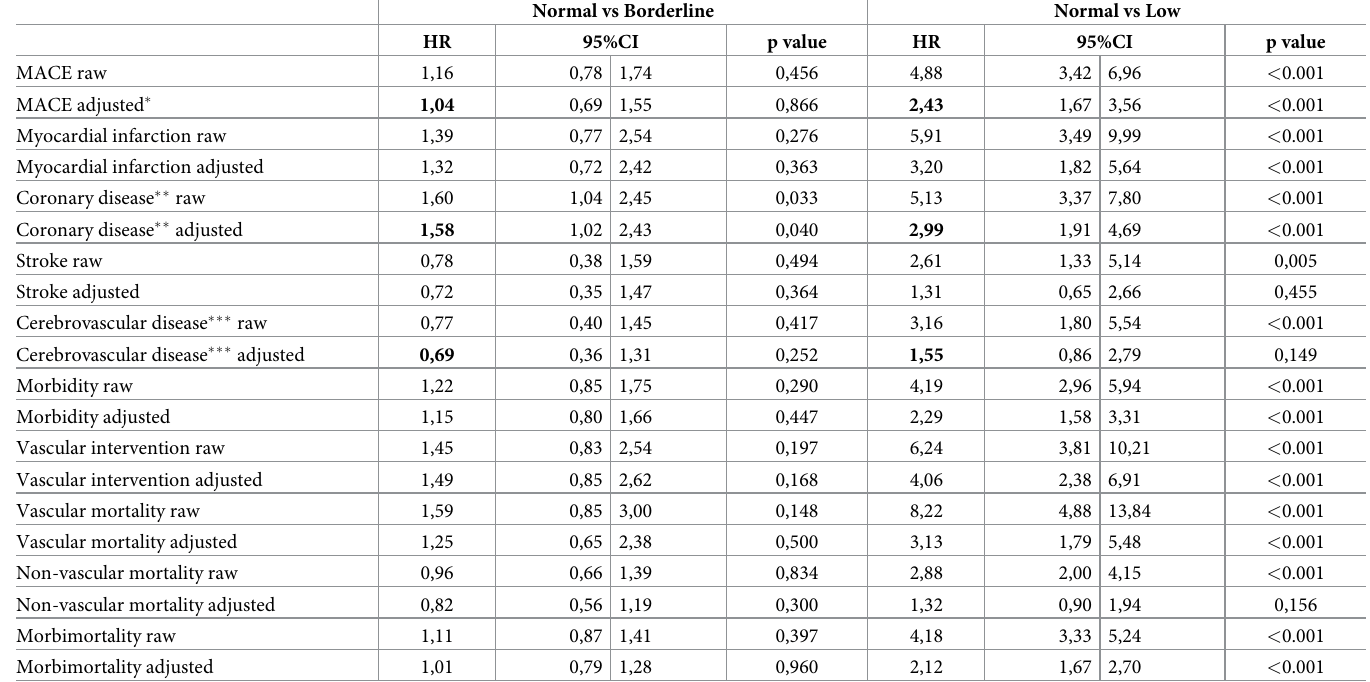
Table 2. Cox proportional regression analysis for clinical